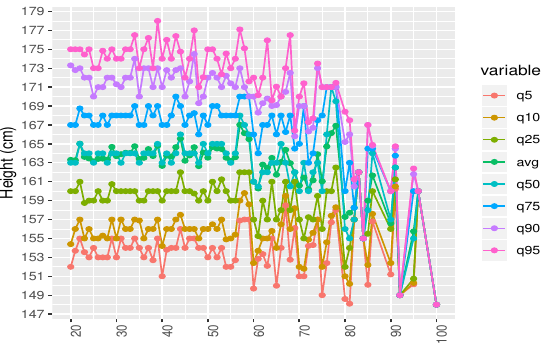
Figure 7. Male Height over Age in seven different quantiles: 5th, 10th, 25th, 50th, 75th, 90th, 95th and the average . The average curve almost overlaps with the 50th quantile.